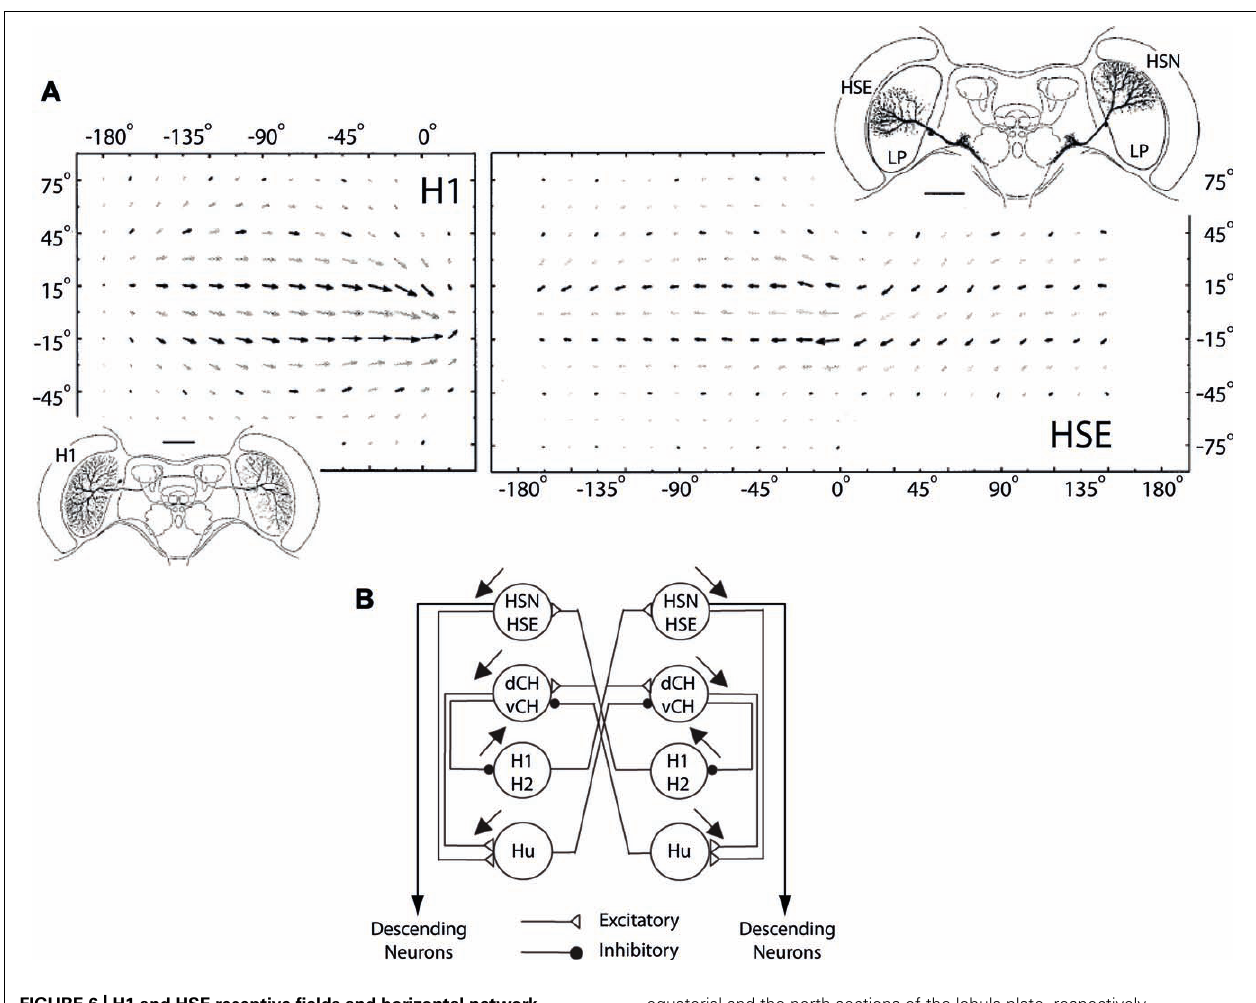
equatorial and the north sections of the lobula plate, respectively (modified from Krapp etal., 2001). (B) The connectivity in the network of LPTCs sensitive to horizontal motion. Excitatory and inhibitory interactions are depicted with open triangles and filled circles, respectively.The HSE and HSN cells receive excitatory input from the contralateral H1 and H2 cells and project onto descending neurons which in turn supply the neck and flight motor systems of the fly (modified from Krapp etal.,